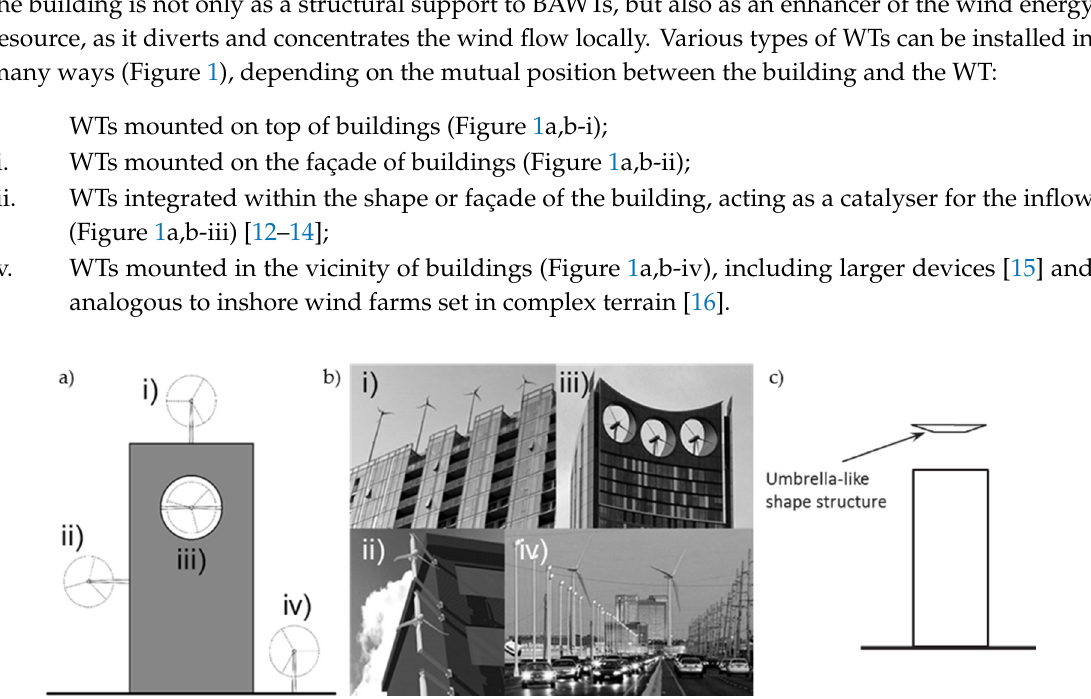
Figure 1. ( a , b ) Wind turbine (WT) and buildings: ( i ) on rooftop, ( ii ) on façade, ( iii ) integrated, ( iv ) in vicinity; ( c ) flow enhancer [17].